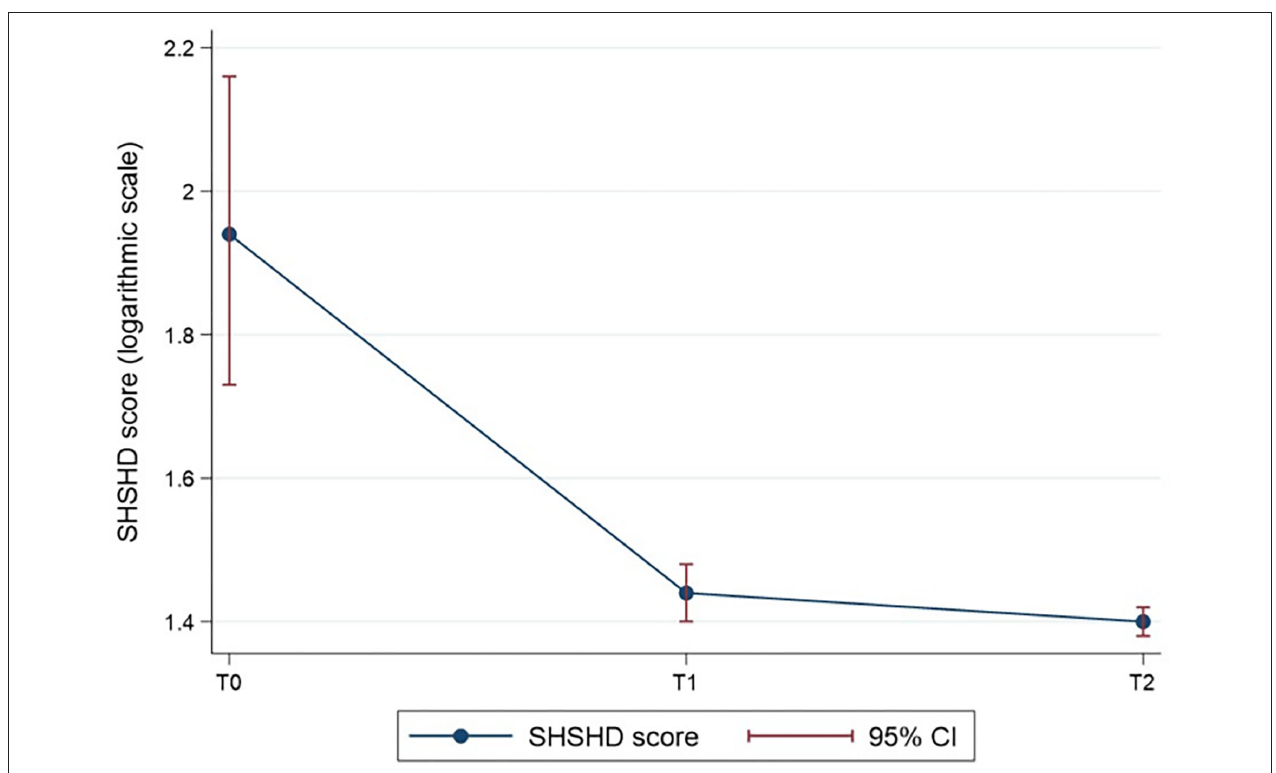
FIGURE 3 | The SHSHD score over time (log-transformed for normalisation of the SHSHD score data). P < 0.001 for T1 vs. T0 and T2 vs. T0.